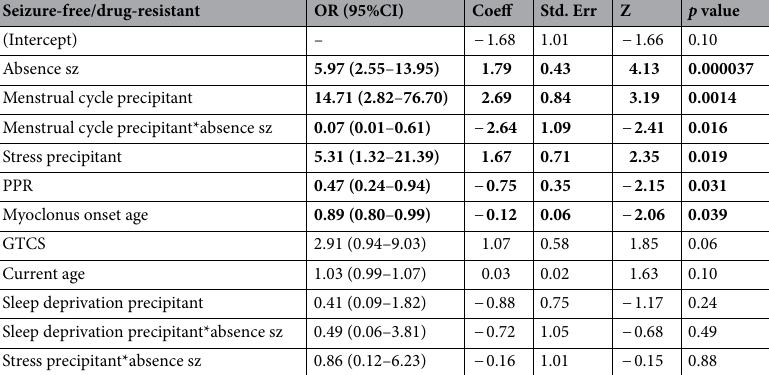
Table 4. Multivariable logistic regression of drug resistance in females (N = 226). Seizure-free coded 0, drug resistant coded 1. OR = Odds ratio; sz = seizure; coeff = coefficient. Bold p values are < 0.05. *Indicates interaction